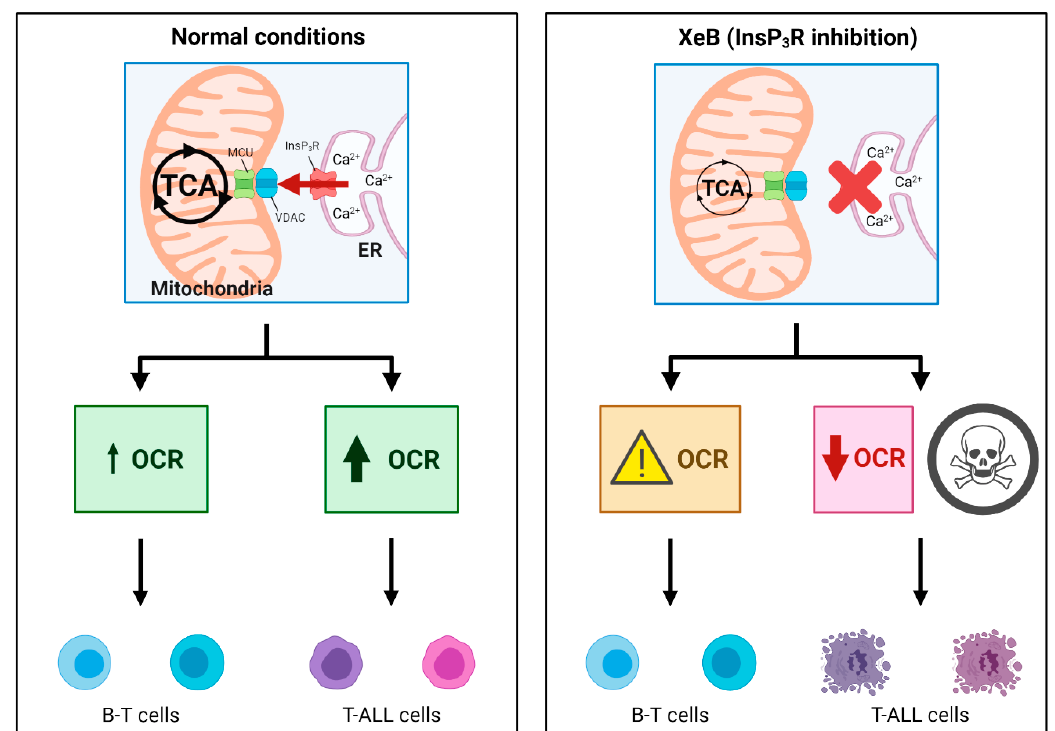
Figure 9. Proposed model for InsP3R-mitochondria communication and viability of T-ALL cells. Under normal conditions, InsP3R constitutively releases Ca 2+ that feeds the mitochondria and stimulates the activity of essential enzymes of the TCA cycle, keeping a constant flux of ATP, reducing equivalents and intermediate metabolites in both normal B and T cells and T-ALL cells. The transfer of Ca 2+ to mitochondria is especially important for T-ALL tumor cell lines, which show higher mitochondrial oxygen consumption rates (OCR) compared with non-malignant cells. Indeed, when InsP3R calcium release is specifically interrupted by XeB treatment, non-malignant cells display a slight decrease in maximal mitochondrial respiration, while T-ALL cells dramatically reduce their mitochondrial respiration and eventually die. This model was created with